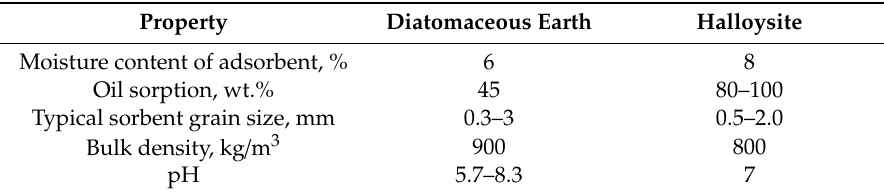
Table 1. Properties of absorbents made of diatomaceous earth from Jawornik deposit and halloysite from the “Dunino” deposit